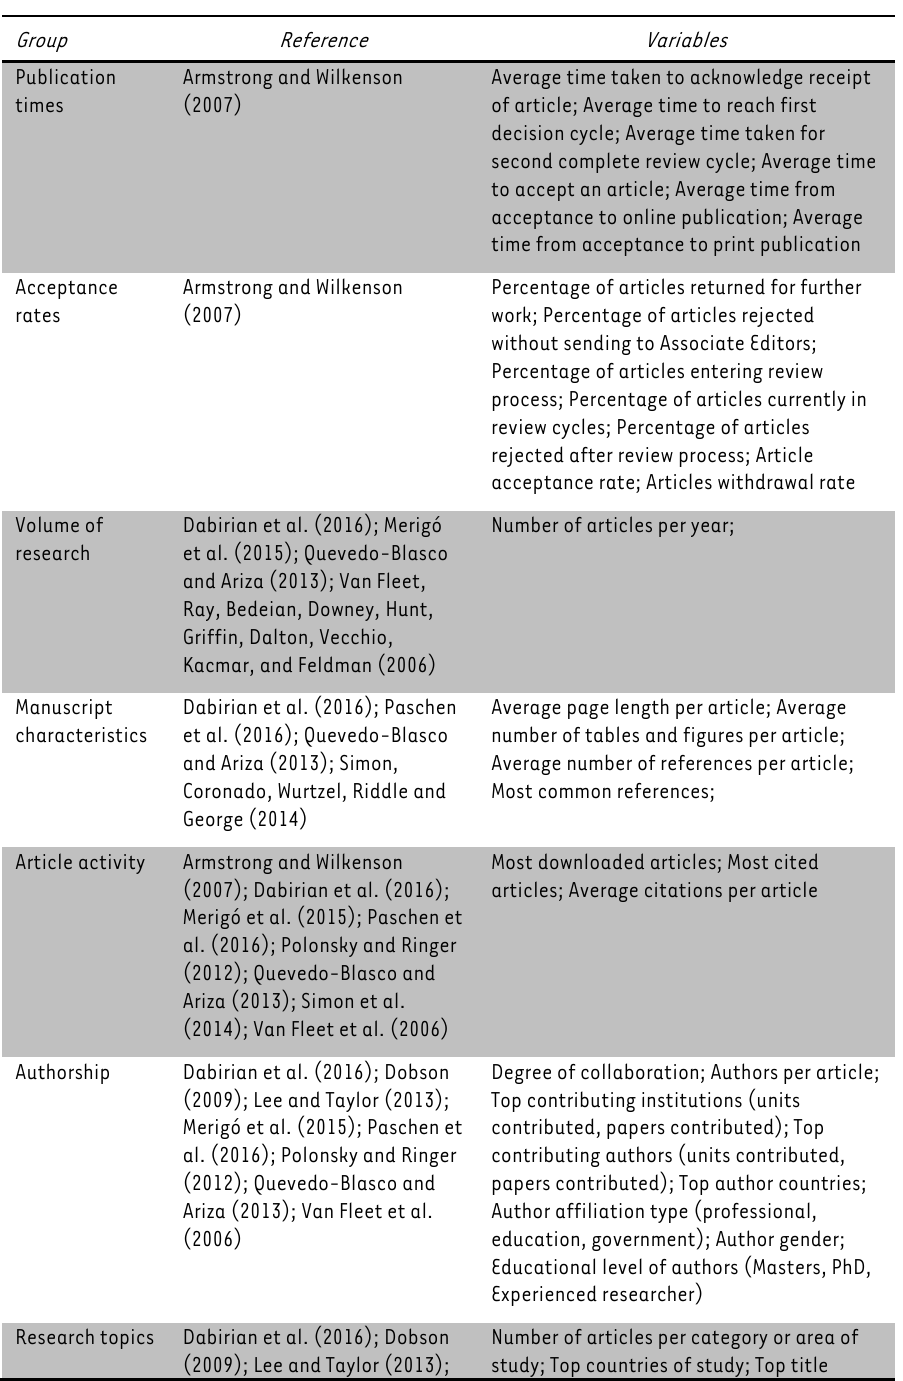
TABLE 1: Common variables of a bibliometric